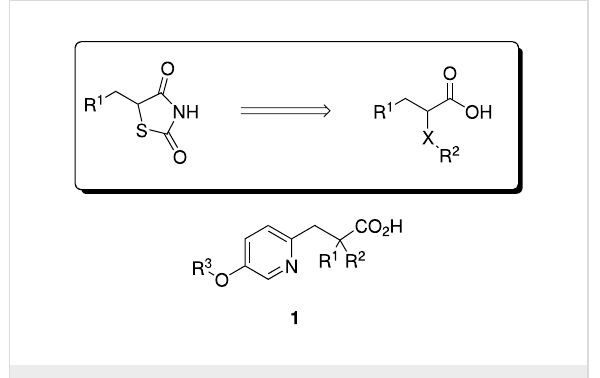
Figure 1: Thiazolidine-2,4-dione mimic & chosen lead scaffold.